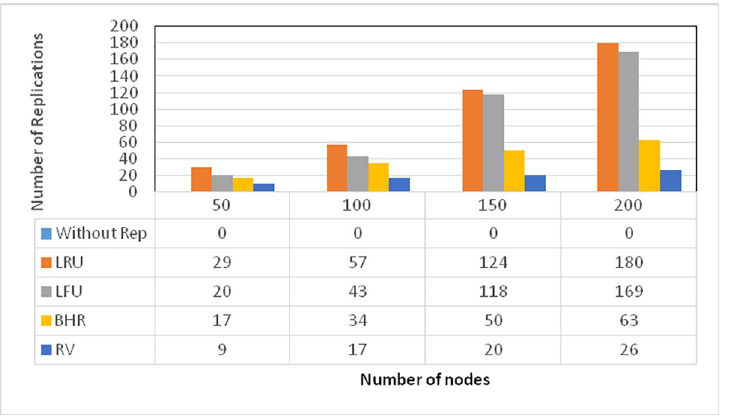
Fig 4. An examination of the number of replications for a variable number of